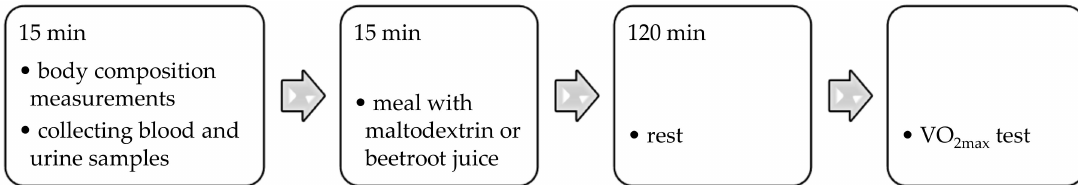
Figure 2. The protocol of laboratory measurements conducted in the group of female and male fencers after each stage of study. The fencers after the first and second stage (B, ID) of the study, before the maximum rate of oxygen uptake test (VO 2max ) consumed a meal with maltodextrin (26 g). Whereas after the third stage of the study (ID&BEET), fencers consumed a meal with freeze-dried beetroot juice (26 g)—both dissolved in